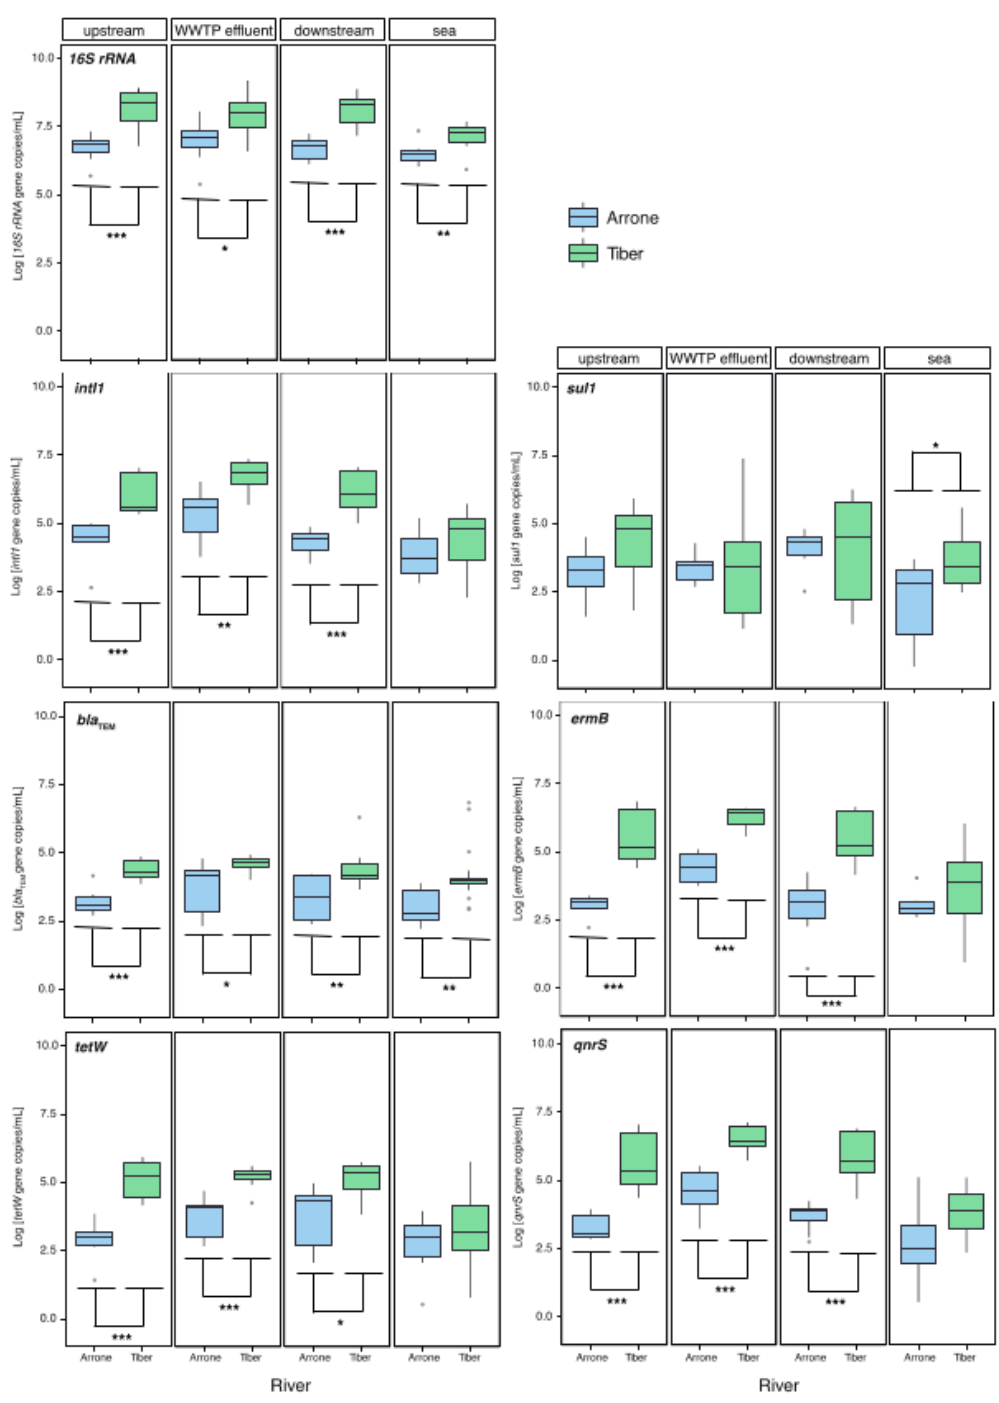
Figure 1. Comparison of the absolute abundance of target genes between studied rivers at the di ff erent sampling sites. The lower and upper edges of each boxplot are the first and third quartiles, the midline shows the median and the whiskers extend from the minimal to the maximal values. Outliers are indicated by gray dots. Asterisks denote statistical significance as follows: * p < 0.05; ** p < 0.01; *** p <